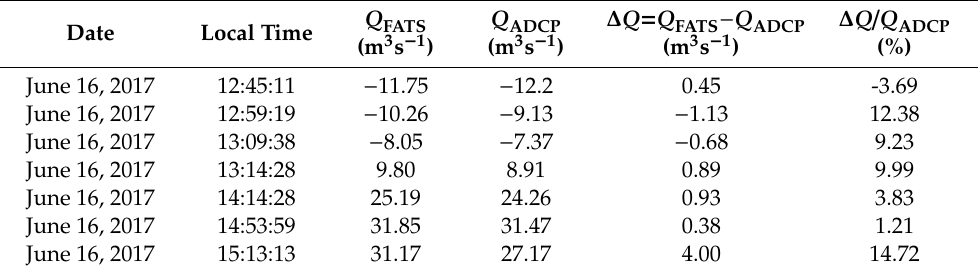
Table 4. Comparison between FATS and ADCP measurements at the western branch.